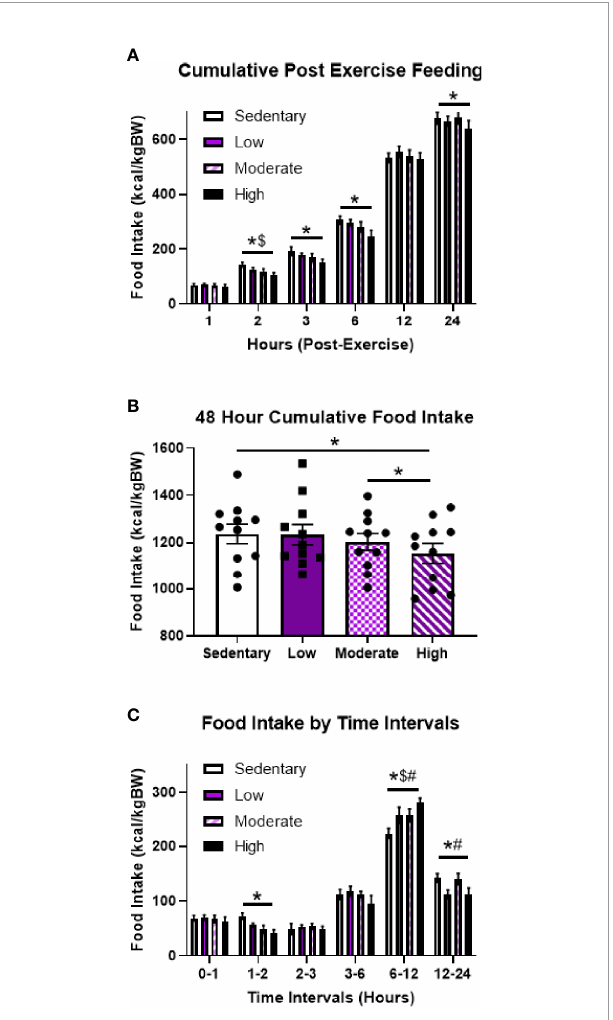
FIGURE 1 | Acute high intensity treadmill exercise suppresses food intake in fasted male mice. (A) Timeline of cumulative food intake, (B) 48-hour cumulative food intake, and (C) food intake by time intervals in fasted male mice in response to different acute treadmill exercise intensities (n = 11). Data represented as mean ± SEM. *indicates p < 0.05 high intensity vs. sedentary; $ indicates p < 0.05 moderate intensity vs. sedentary; # indicates p < 0.05 low intensity vs.